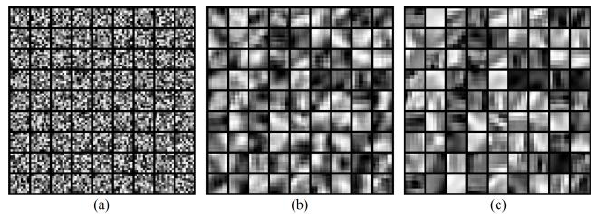
Figure 5 . The effect of the number of iterations on sub-images with a size of 9×9 pixels; (a) zero iteration, (b) one iteration, and (c) four